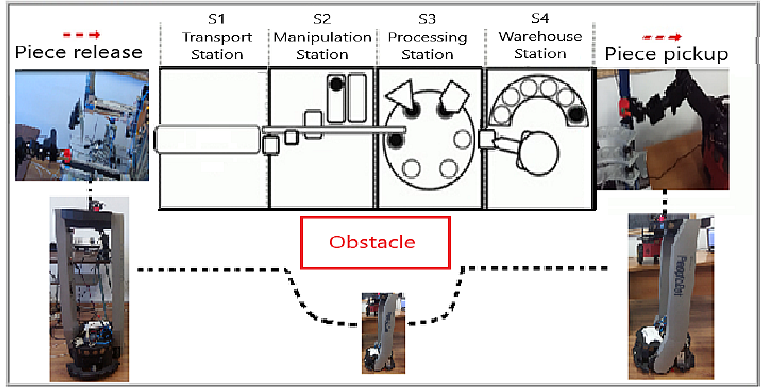
Figure 15. Trajectory with obstacle avoidance of ARS PeopleBot assisting P/RML.